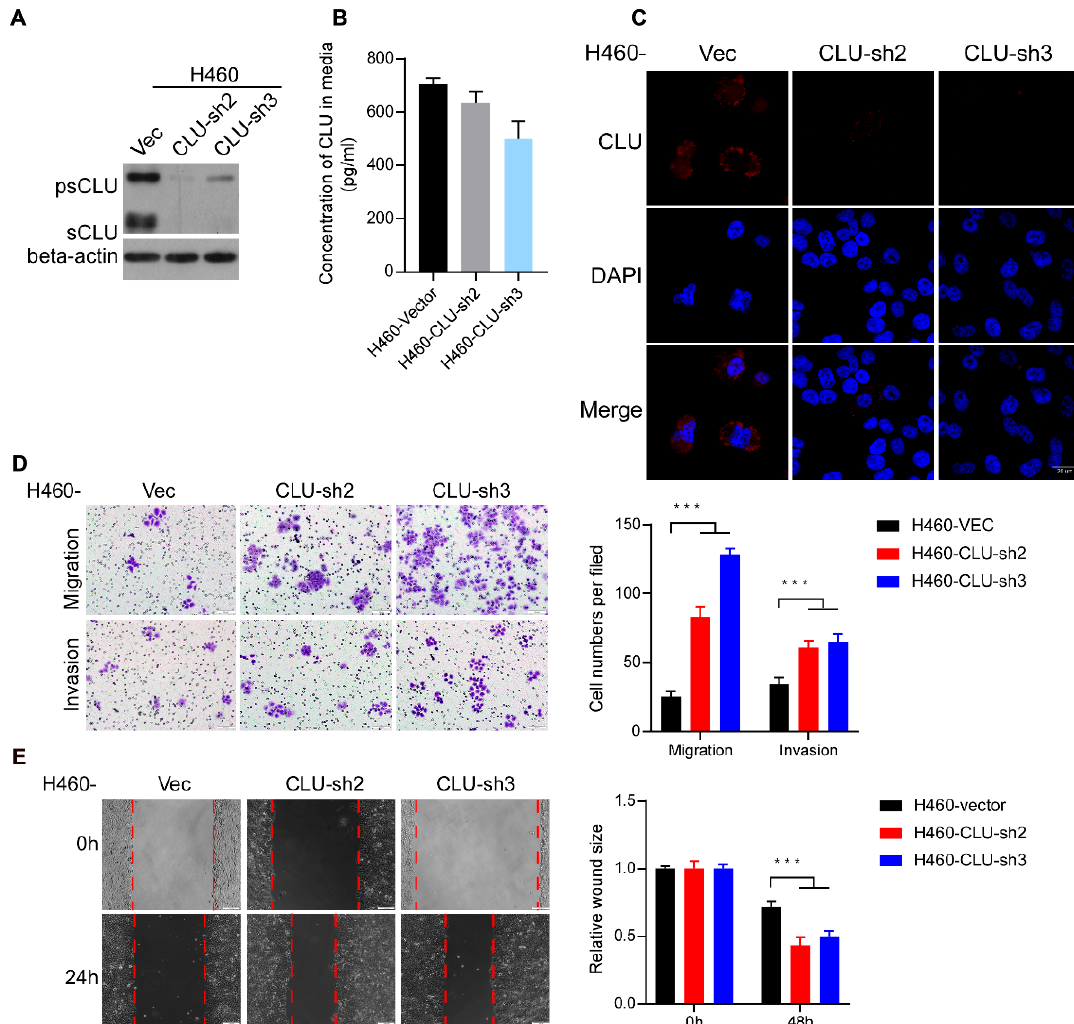
Figure 3. Silencing CLU promotes lung cancer invasion and migration. ( A ) The protein level of CLU in CLU-silenced H460 cells compared to vector-control cells. GAPDH was used as a loading control. ( B ) The concentration of sCLU in H460 cells was detected by ELISA assay. ( C ) Representative micrographs of immunofluorescence for intracellular CLU distribution in CLU-silenced H460 cells and vector-control cells. ( D ) Representative images of Transwell assay and relative quantification of the migration or invasion cells in CLU-silenced H460 cells and vector-control cells. ( E ) Representative images of wound-healing assay and relative wound size in CLU-silenced H460 cells and vector-control cells. Results are presented as mean ± SD, *** p < 0.001, ns means no significance.